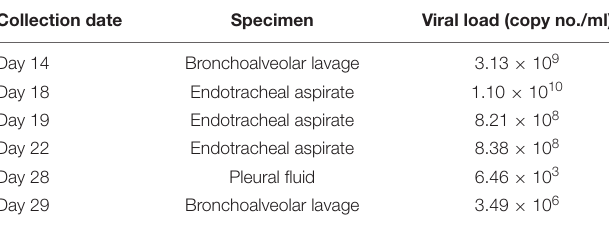
TABLE 1 | Viral loads of different respiratory samples collected from the patient infected with the novel HCoV-OC43 genotype at different time